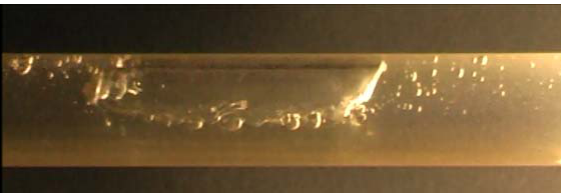
Fig. 3. Small bubble formed in the slug flow.